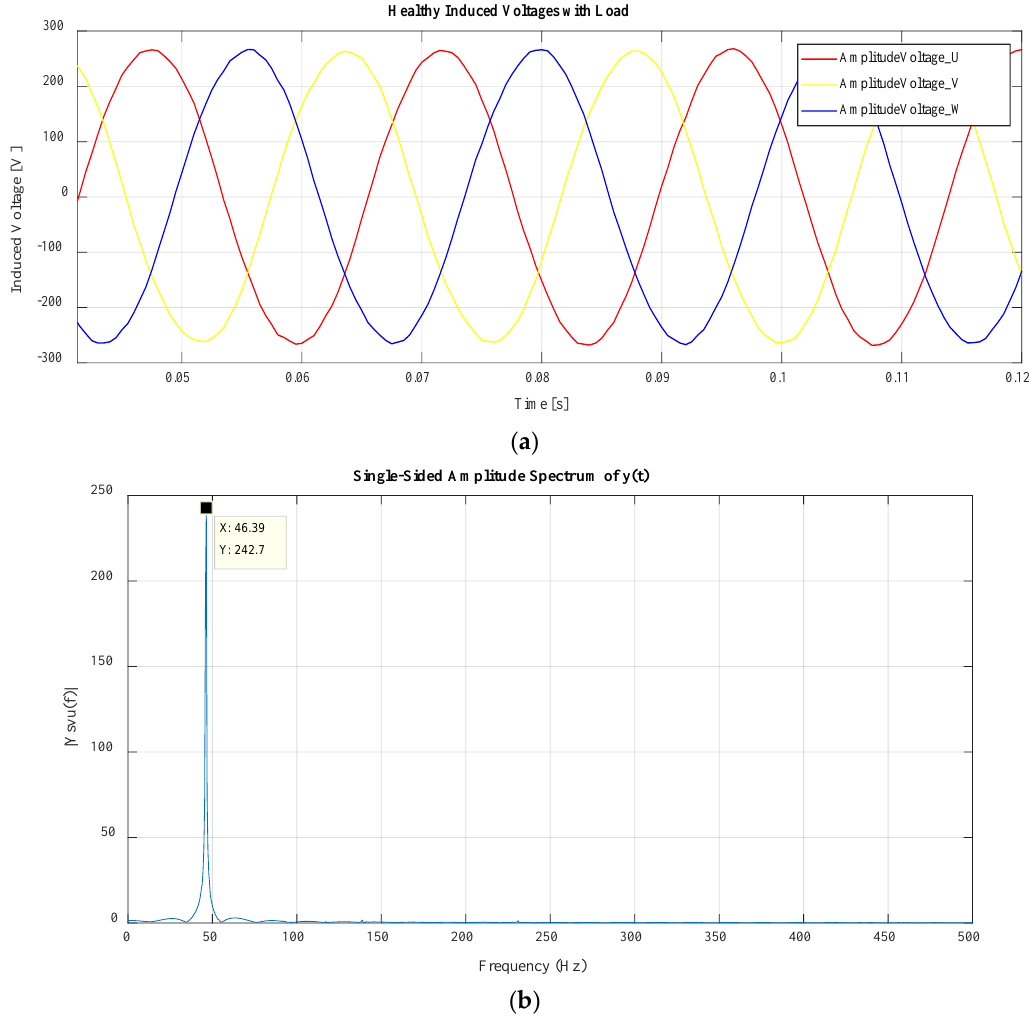
Figure 3. ( a ) Three-phase steady − state stator phase voltage shown for a portion of acquisition time used; ( b ) stator voltage phase U under healthy conditions.